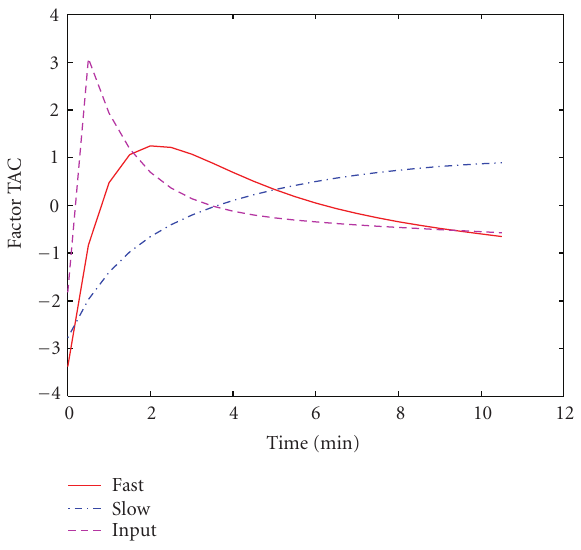
Figure 3: The estimated TACs derived from real DCE-MRI data by maximum likelihood